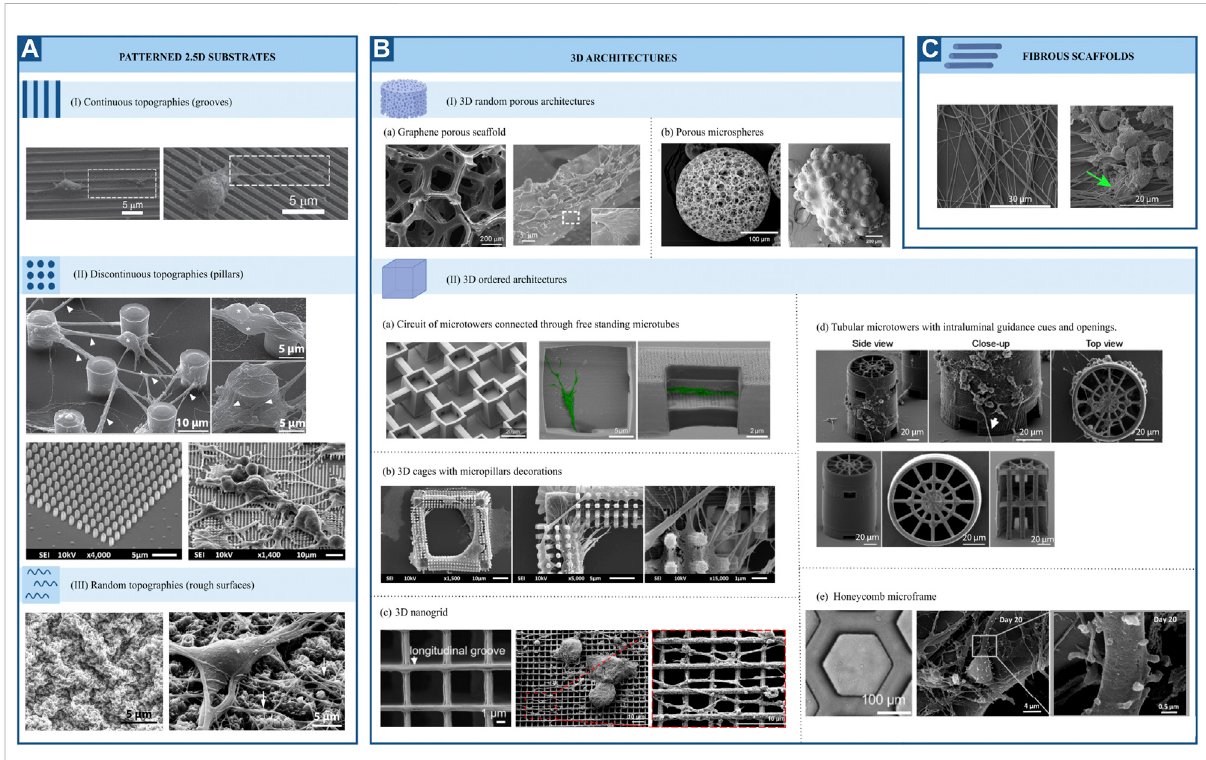
FIGURE 5 Representative SEM pictures of different topographies employed for neuromechanobiological studies (adapted end reproduced with permission from the mentioned references). (A) Patterned 2.5 substrates. (I) Continuous topographies (Fozdar et al, 2010), (II) Discontinuous topographies (Limongi et al, 2013; Sharaf et al, 2022) and (III) Random topographies (Cesca et al, 2014). (B) 3D architectures. (I) 3D random porous architectures (a) Li et al, 2013; (b) Sandhurst et al, 2022 (II) 3D ordered architectures (a) Harberts et al, 2020; (b) Sharaf et al, 2022; (c) Agrawal et al, 2021; (d) Turunen et al, 2017; (e) Left (phase contrast image): Huang et al, 2021 and middle and right: Koroleva et al, 2021. (C) . Fibrous scaffolds (Czeisler et al,